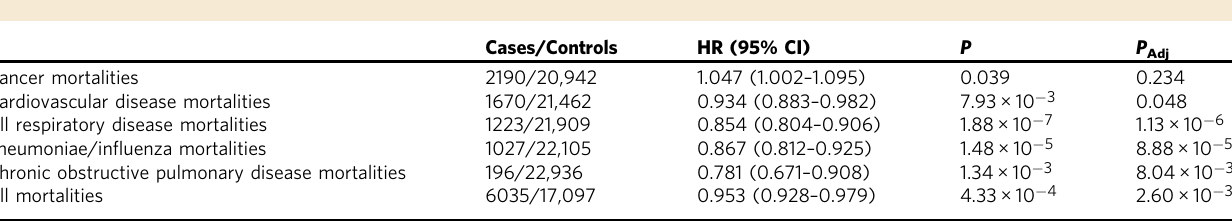
Table 3 Association of Z -score for LTL with various mortalities in the SCHS dataset